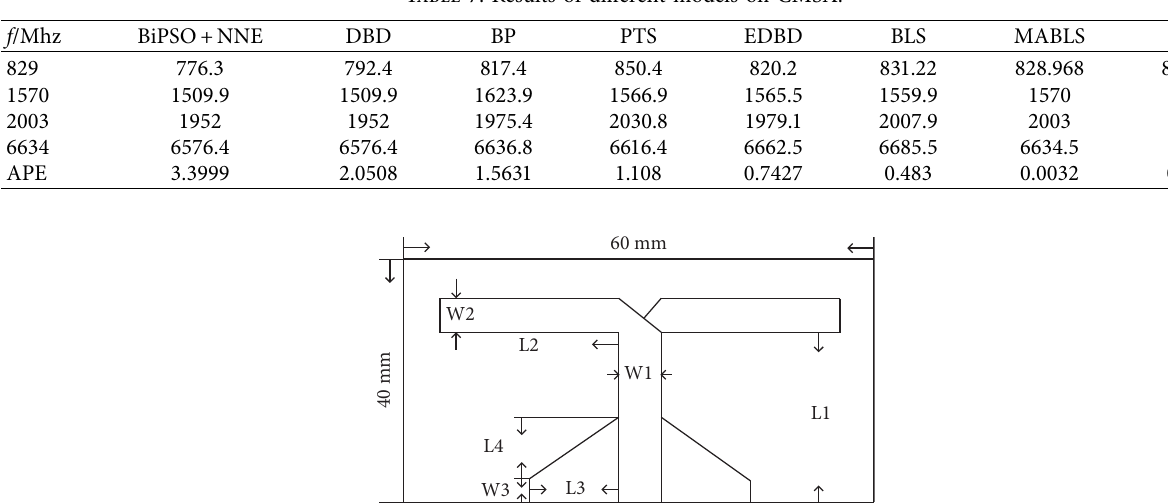
Table 7: Results of different models on CMSA.